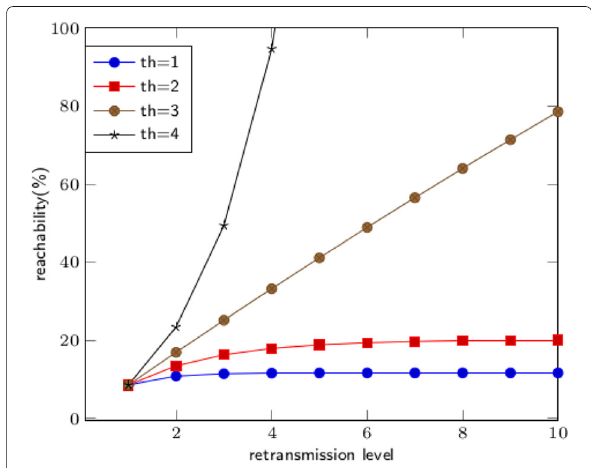
Fig. 19 Reachability with retransmission level in a MANET having density 100